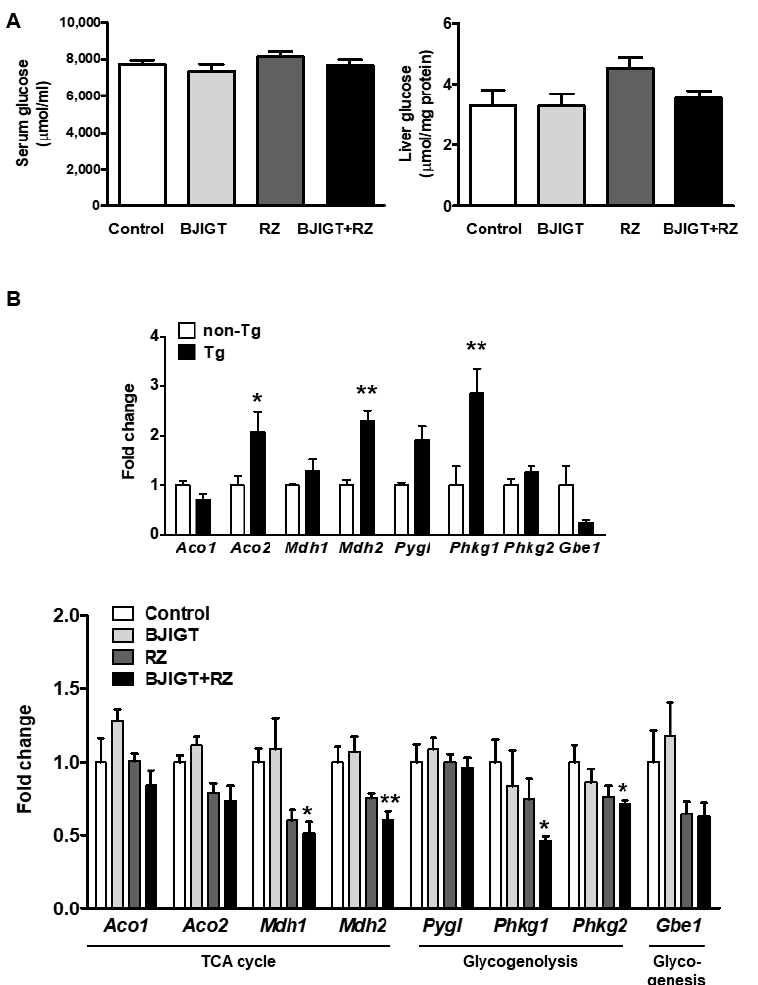
Figure 6. Combined administration of BJIGT and RZ ameliorated metabolism-related protein ex- pression in the liver of hSOD1 G93A mice. ( A ) Levels of glucose in the serum and liver of each group. ( B ) Gene expression of the TCA cycle ( Aco1 , Aco2 , Mdh1 , Mdh2 ), glycogenolysis ( Pygl , Phkg1 , Phkg2 ), and glycogenesis ( Gbe1 ) in the livers of non-Tg and Tg mice. * p < 0.05, ** p < 0.01 vs. non-Tg. n = 4 mice per group. Gene expression of the TCA cycle ( Aco1 , Aco2 , Mdh1 , Mdh2 ), glycogenolysis ( Pygl , Phkg1 , Phkg2 ), and glycogenesis ( Gbe1 ) in the liver. mRNA was quantified by qPCR, and the resulting values were expressed as relative mRNA expression levels after normalization to GAPDH. Data are presented as the mean ± SEM; * p < 0.05, ** p < 0.01, vs. control. n = 5–9 mice per experimental group.